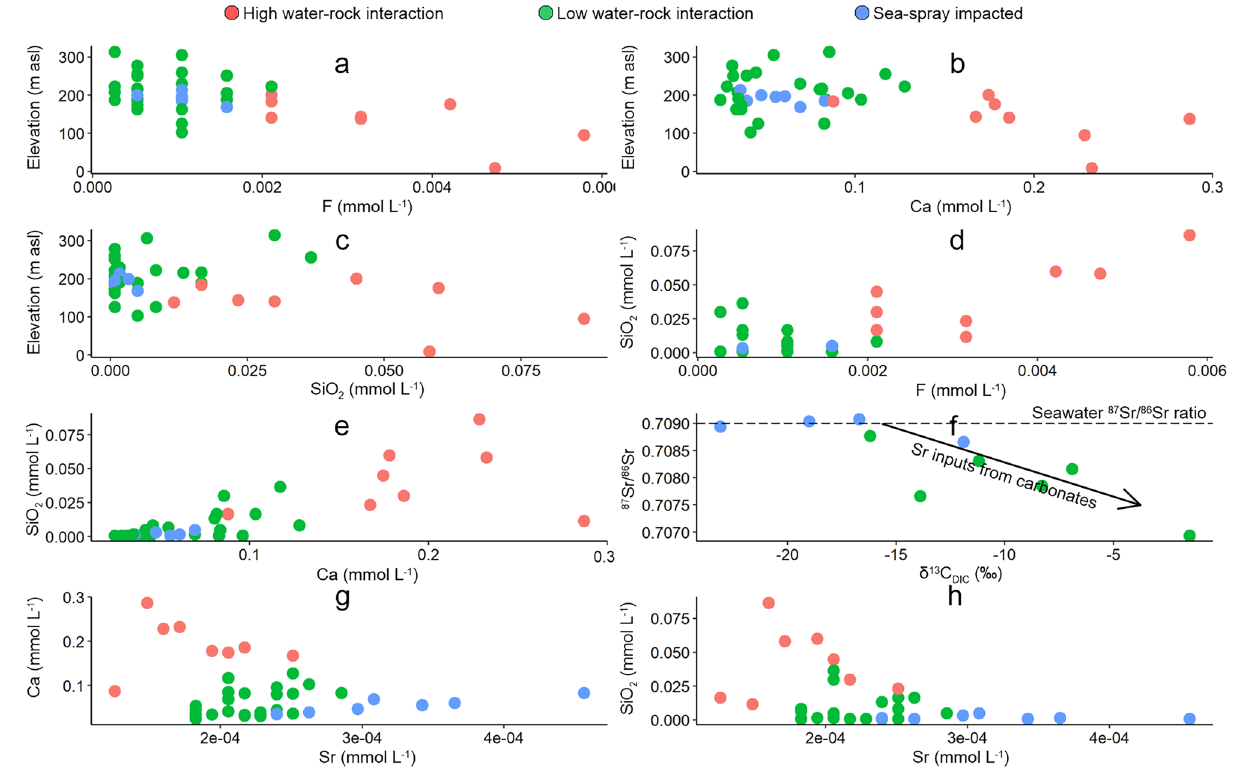
13 C 87 Sr/ 86 Sr), ( g ) Sr 2 ) vs. elevation, ( d ) F vs. SiO 2 , ( e ) Ca vs. SiO 2 , ( f ) δ DIC (‰) vs. strontium isotope ratios ( vs. Ca and ( h ) Sr vs. SiO 2 . Lakes are coloured by cluster with red, green and blue points representing lakes with high sea-spray input and samples which have undergone high and low water–rock interaction (cluster groups 1, 2 and 3 respectively in Fig. 3a). Notably, the highest 87 Sr/ 86 Sr values (n = 10) in the dataset are associated with sea-spray inputs including SO 4 , Br, Cl, Na and